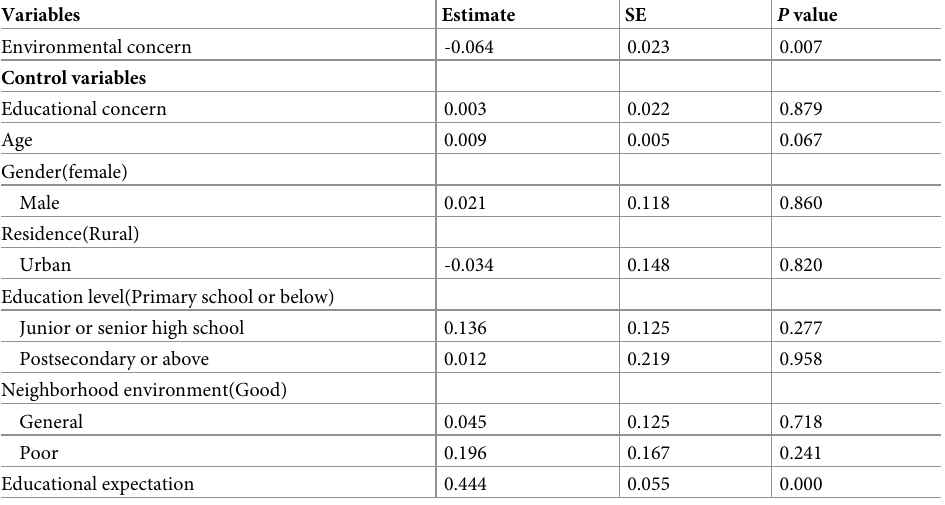
Table 2. Model estimates for expected educational level of sending children to study